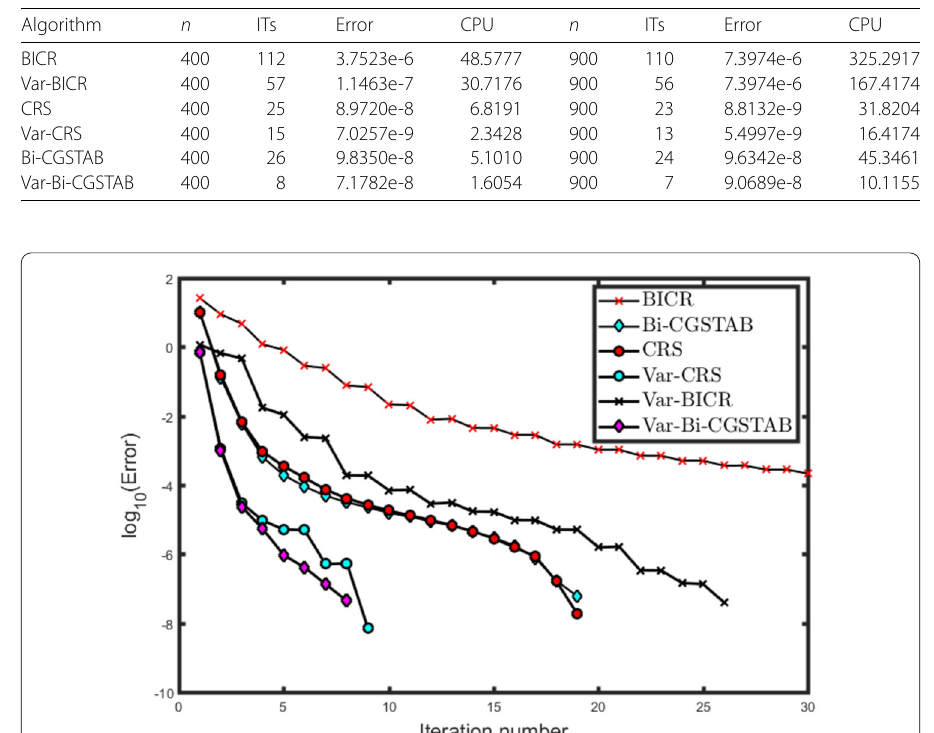
Figure 2 Comparison between the residual error of Algorithms 1 to 6 for Example